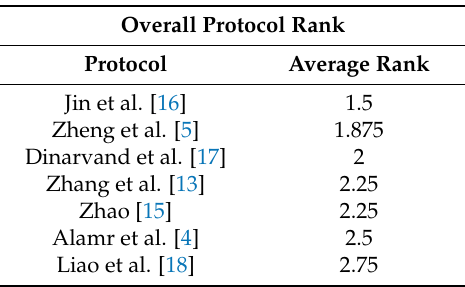
Table 14. Sorted rank of each protocol based on the average of all their